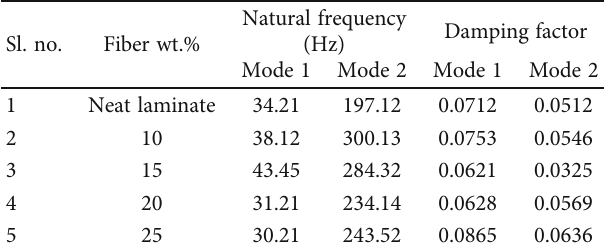
Table 3: Variation of natural frequency and modal damping factor with varying bamboo fi ber weight percentage in polyester resin